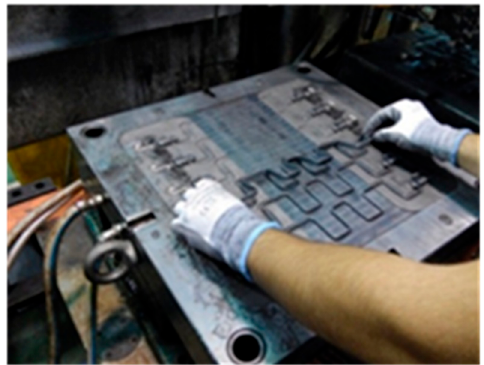
Figure 4. Operator inserting 2D bent wires into of the two lower half-mold. The over-molding is made on both tips of the bent wires (cavities).